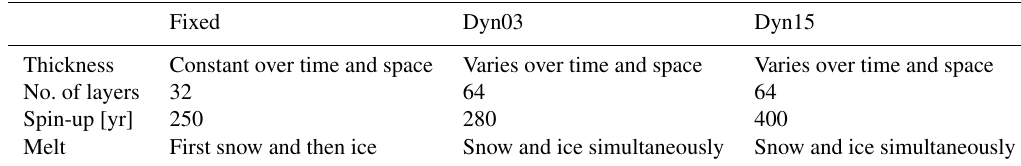
Table 1. Model overview and main differences.